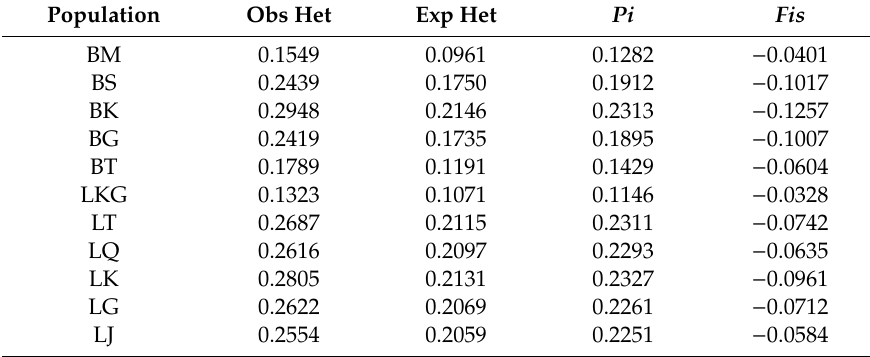
Table 2. Genetic diversity indices for two Scizothoracins calculated using genome single-nucleotide polymorphism (SNP).